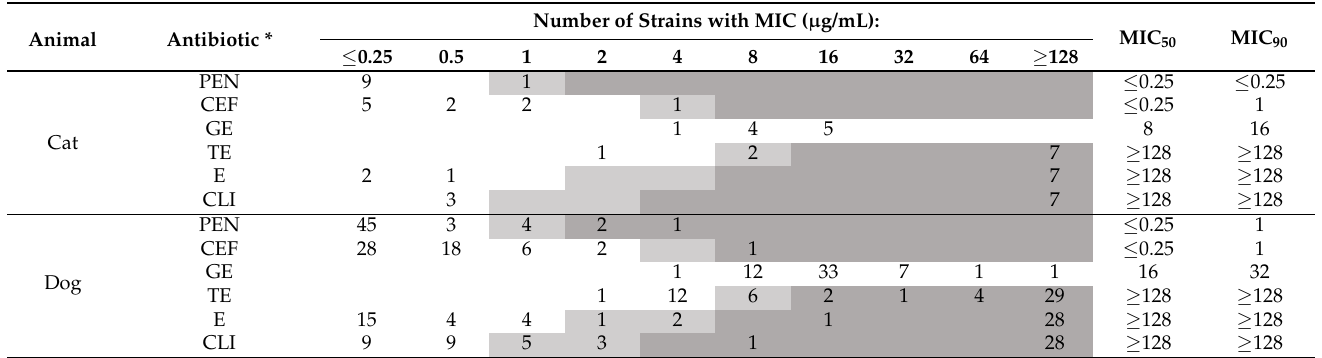
Table 1. Distribution of Minimum Inhibitory Concentration (MIC) of six antimicrobial agents, MIC 50 and MIC 90 values for the studied S. canis strains from cats ( n = 10) and dogs ( n = 55).